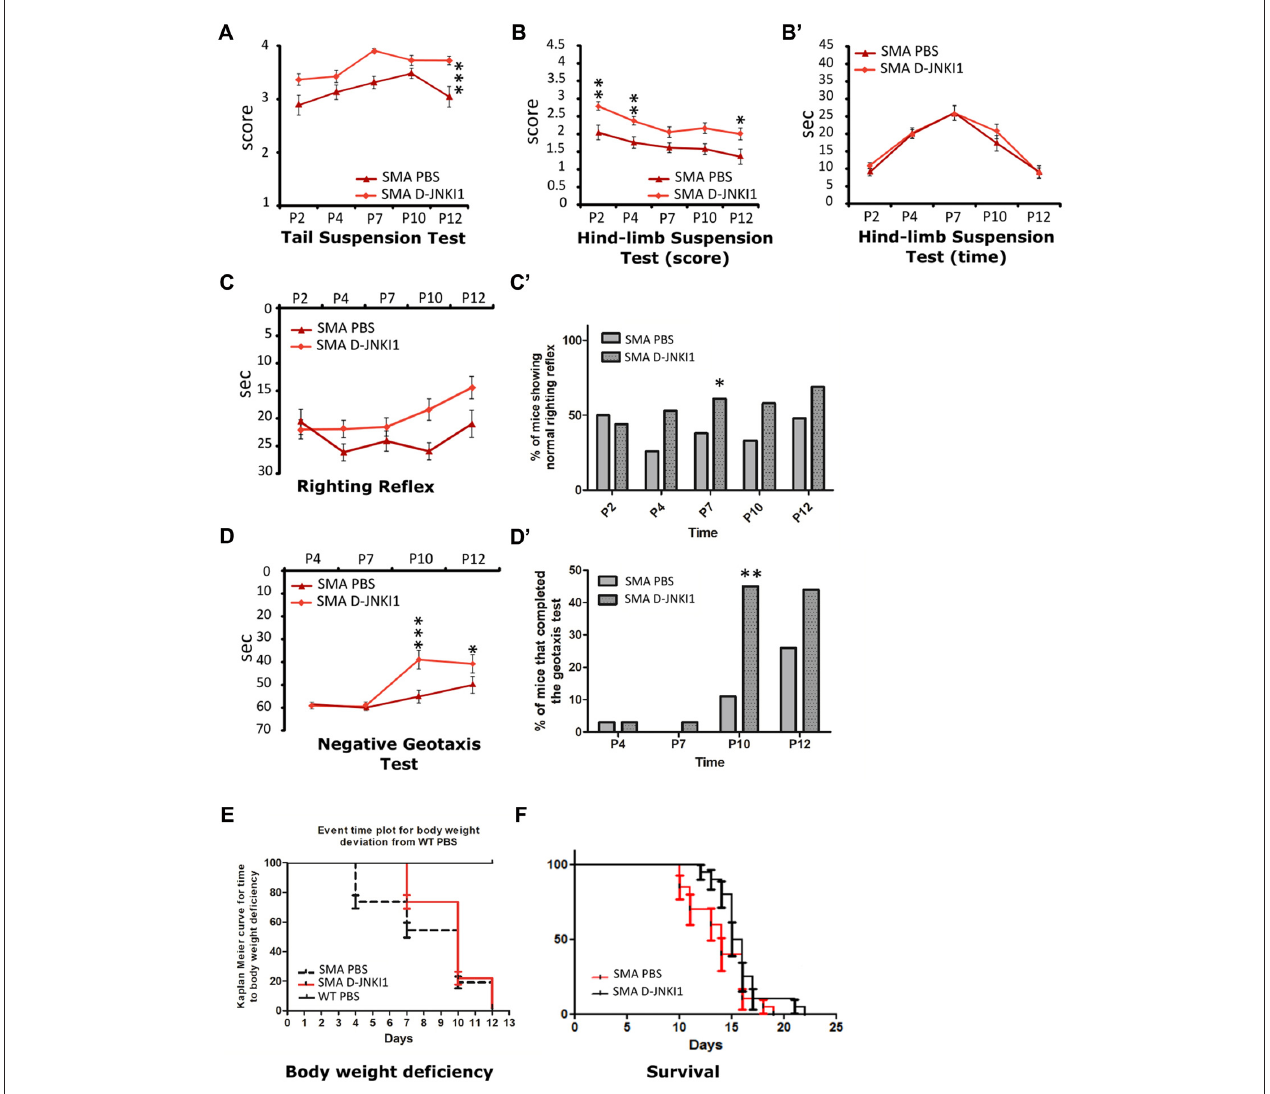
FIGURE 7 | D-JNKI1 treatment improves overall state of wellbeing and motor performances in behavioral tests. Tail suspension test (A) , hind-limb suspension test score (B) and time (B’) , righting reflex test (C,C’) and negative geotaxis test (D,D’) have been used to evaluate the motor performances of PBS- and D-JNKI1-treated SMA mice. (E) Event time plot for body weight deviation of PBS SMA. D-JNKI1 SMA and PBS WT (Kaplan-Meier curve, Log-rank Mantel Cox test, p < 0.05). (F) Kaplan-Meier survival curve shows that D-JNKI1 treatment can significantly extend SMA lifespan ( p < 0.05). ∗ P < 0.05; ∗∗ P < 0.01; ∗∗∗ P <